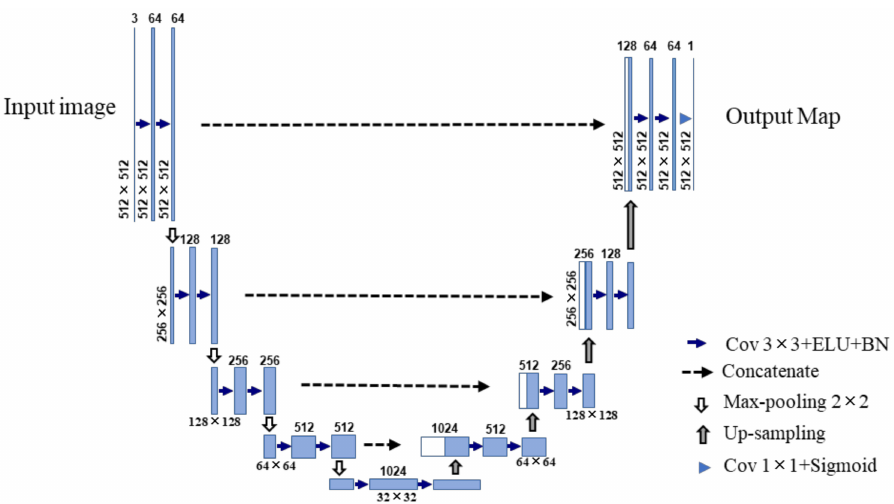
Figure 2. The architecture of the modified